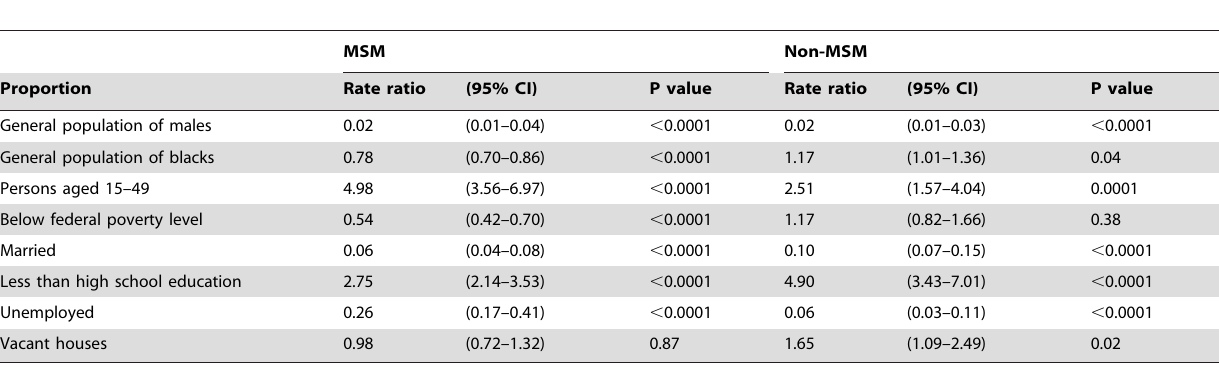
Table 2. HIV diagnosis rate ratios among black/African American MSM and non-MSM, by selected census tract–level social determinants of health, 2005–2009—17 areas.